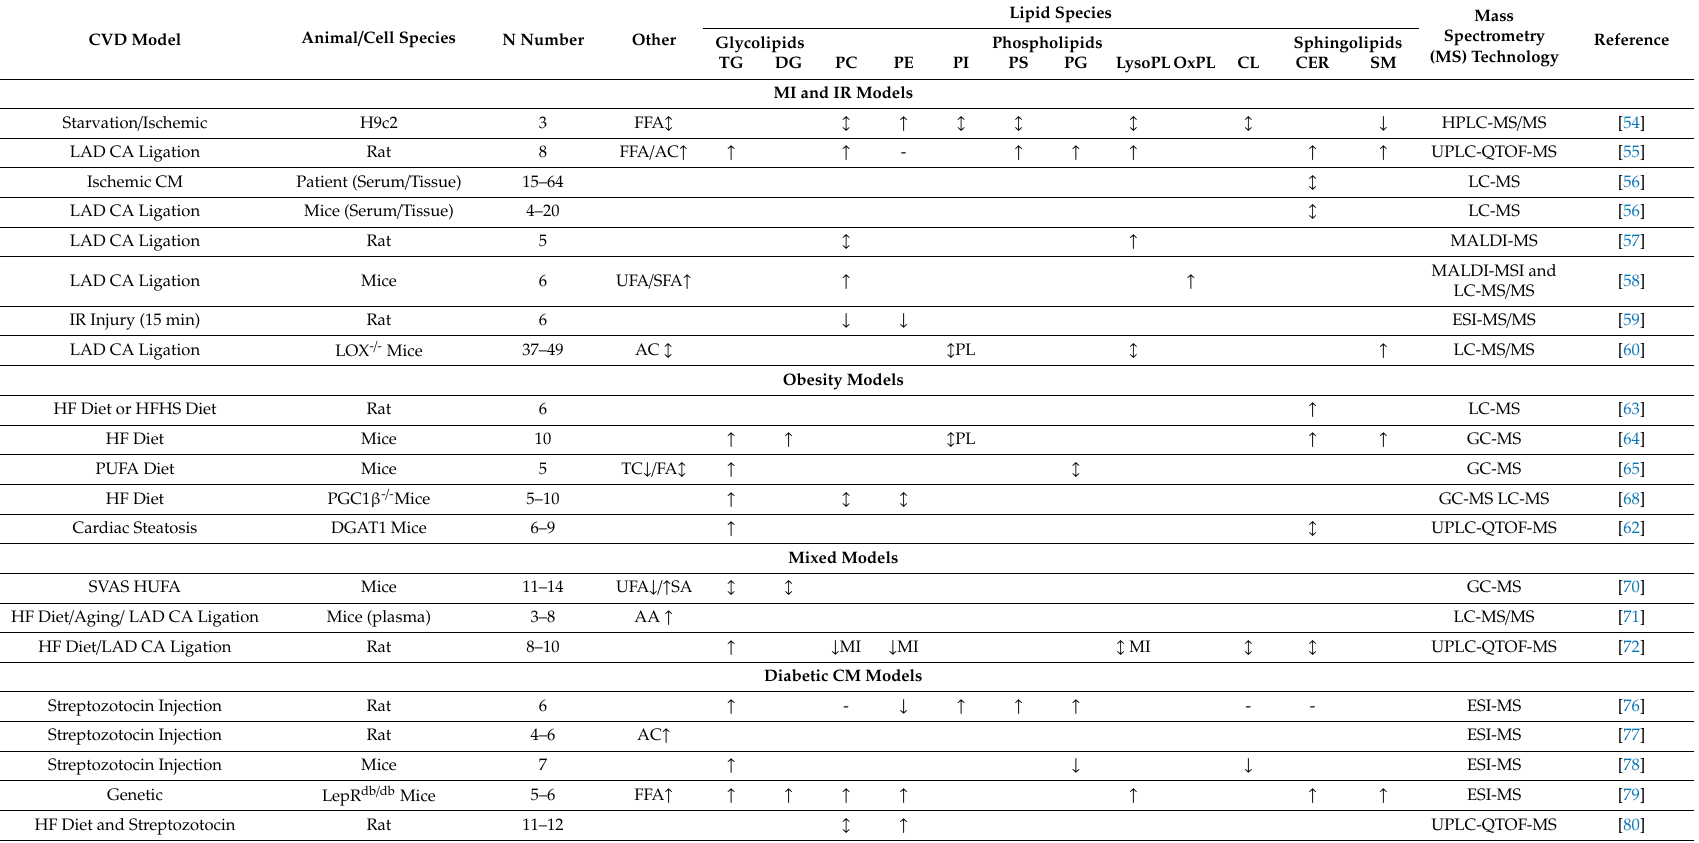
Table 2. Summary of lipidomics studies in models of cardiovascular disease by mass